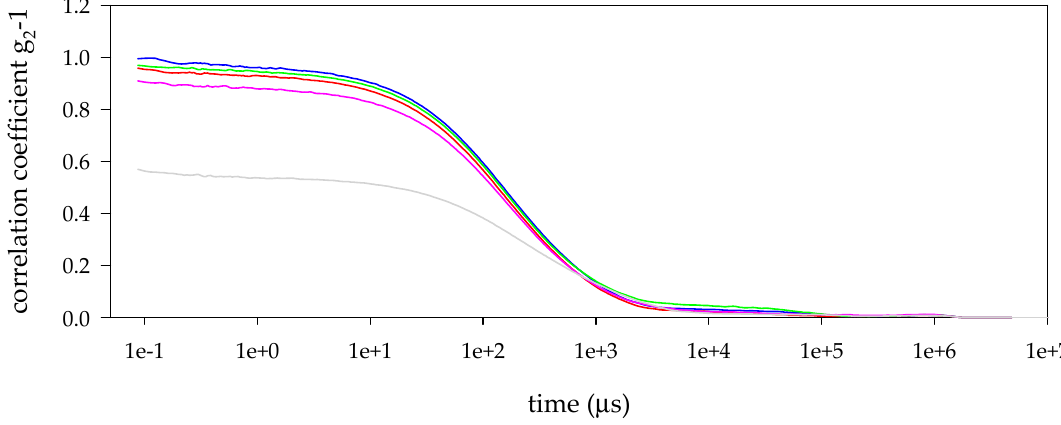
Figure 2. Correlation function of mucin type III from Sigma-Aldrich at 1.25 (blue), 0.625 (red), 0.313 (green), 0.156 (pink), and 0.078 mg/mL (grey).